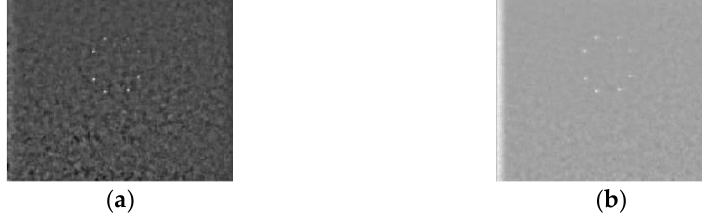
Figure 9. Reflection images of red and green components: ( a ) reflection image of red components; ( b ) reflection image of green components.